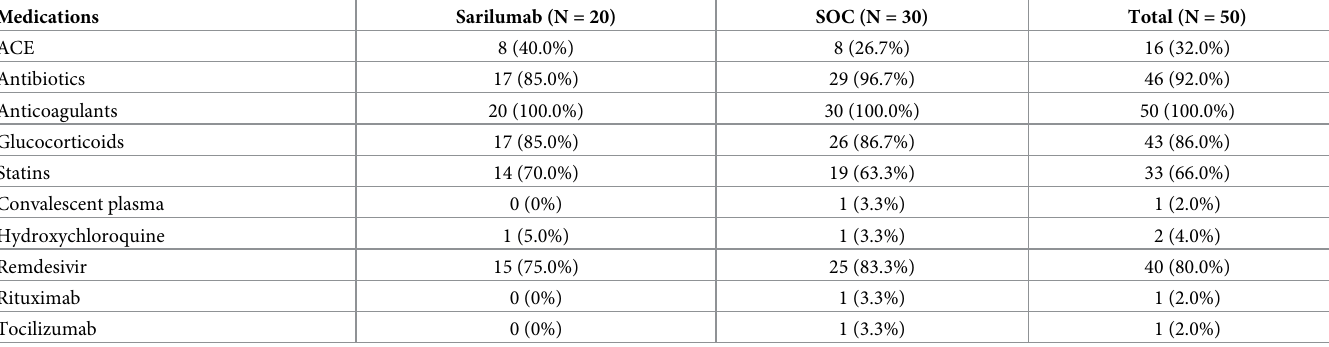
Table 3. Medication administration during COVID hospitalization by drug